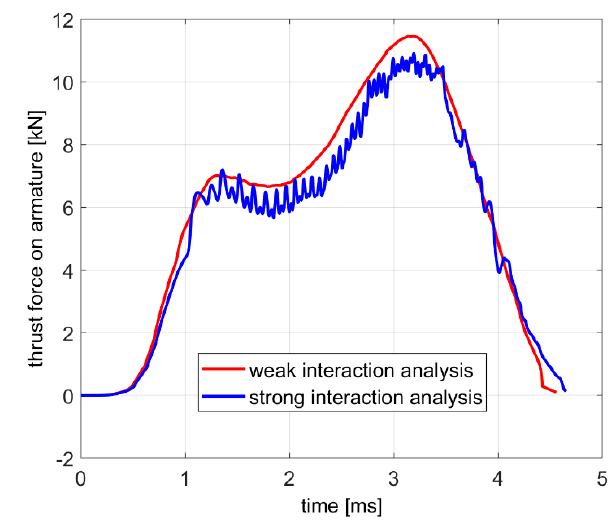
Figure 12. The thrust force on the armature in the strong and weak interaction. The ripple is an artifact due to the commutations that happen in the auxiliary network used to manage the sliding contacts in the strong interaction analysis.